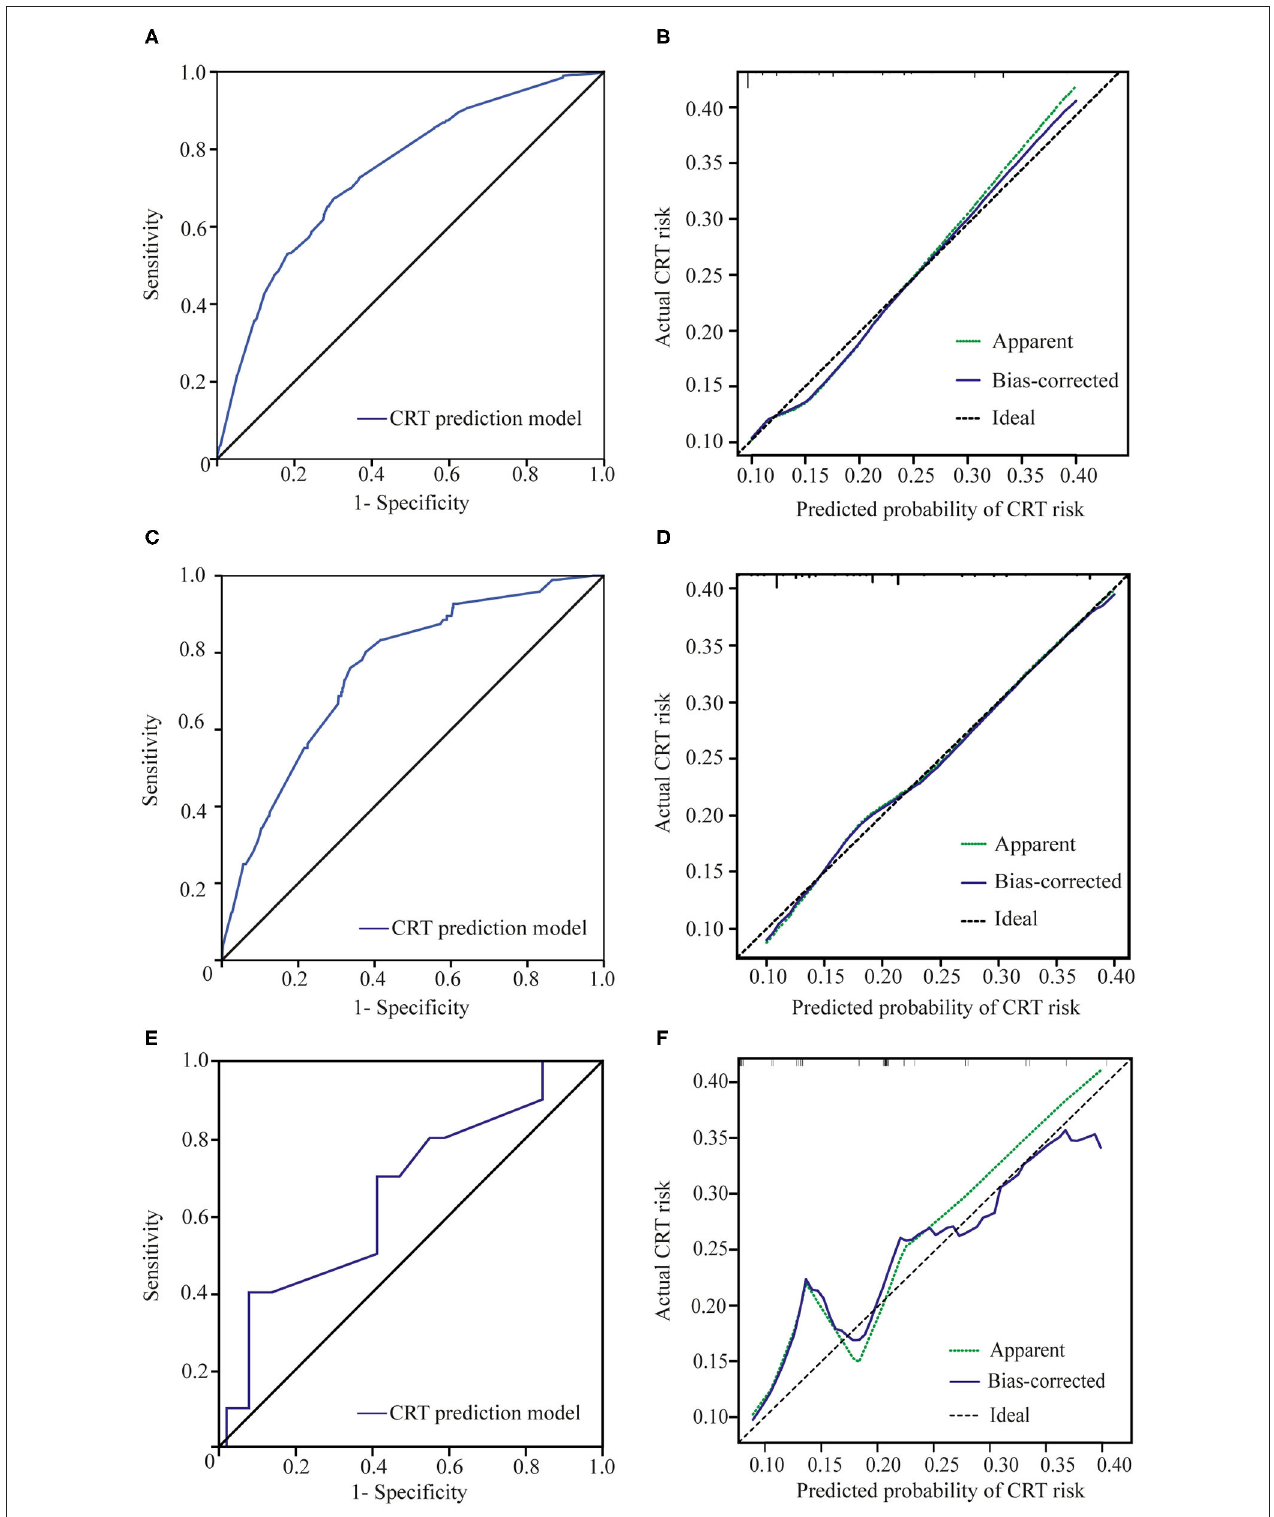
FIGURE 2 | Receiver operating characteristic (ROC) curves and calibration plots. (A) ROC curve of the CRT prediction model in the primary cohort. (B) The calibration plot for the risk of CRT in the primary cohort showed optimal agreement between the prediction and actual observation. The apparent line is the in-sample